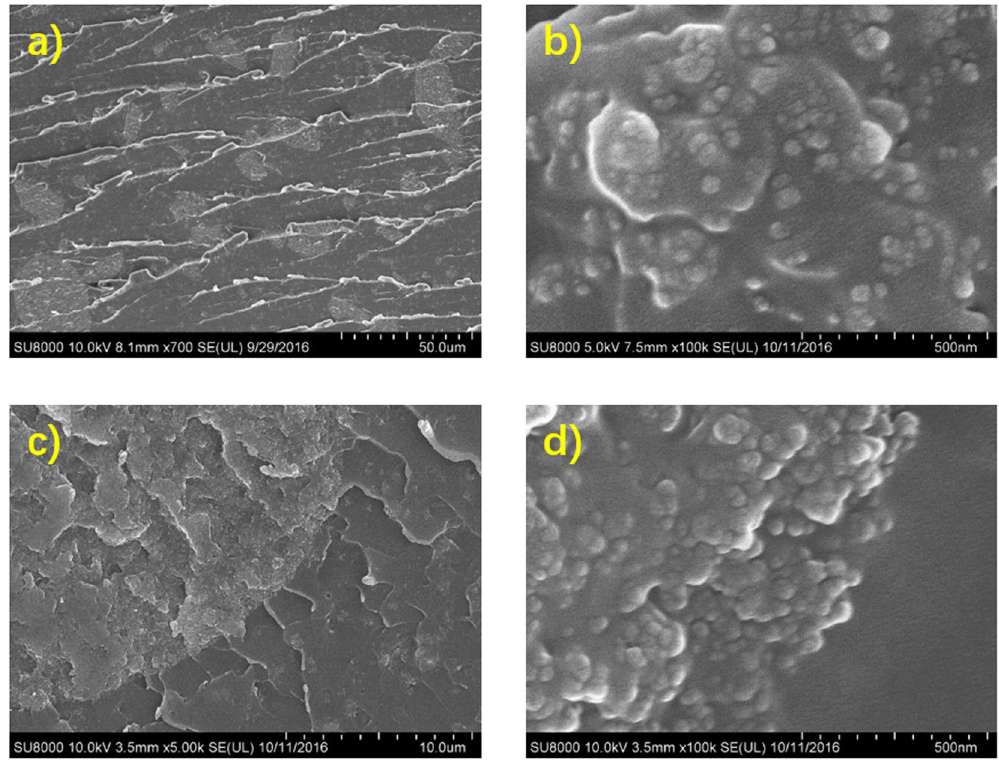
Figure 1. Particle dispersion in ( a ) the micro composite and ( b ) the nano composite. ( c ) A quarter of one micro SiO2 particle in the micro-nano composite. ( d ) The nano SiO2 particles on the surface of the micro SiO2 particle in the micro-nano